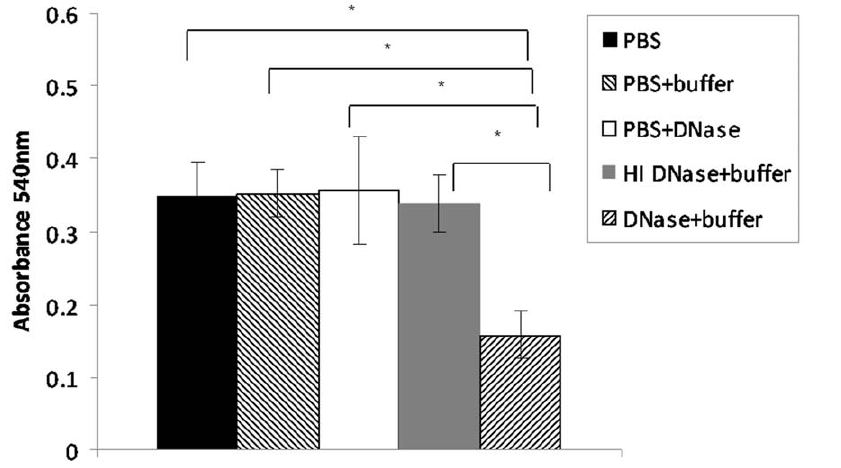
Figure 3. DNase I leads to the disruption of established Bordetella biofilms grown in microtitre plates. Preformed 48h RB50 biofilms grown in 96 well plates were rinsed with PBS followed by incubation with PBS, PBS and reaction buffer, PBS and DNase I, PBS and heat inactivated (HI) DNase I, or PBS with reaction buffer and DNase I. Biofilm formation was then quantitated via crystal violet staining. Each point is an average of at least 6 wells, and error bars indicate the standard deviation. Asterisks designate a value of P , 0.05 (students t -test).